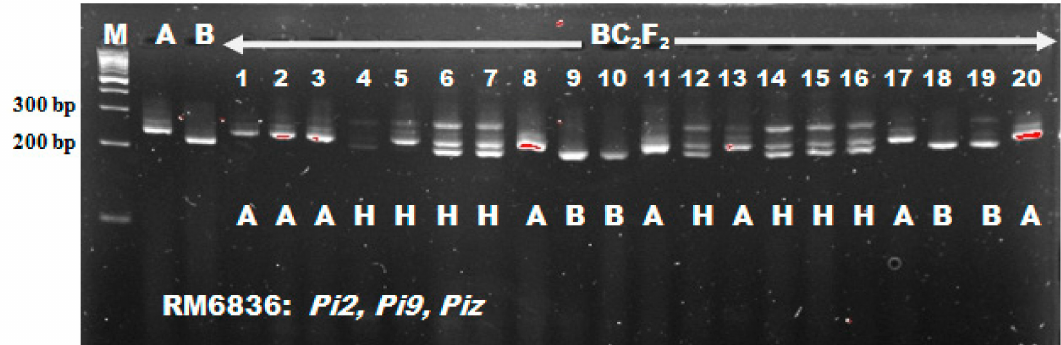
Figure 4. Genotyping and foreground marker-assisted selection of BC 2 F 2 progenies using polymorphic tightly linked marker. Note: Only homozygous “A” allele for blastresistance genes were selected at BC 2 F 2. M: 100 bp DNA